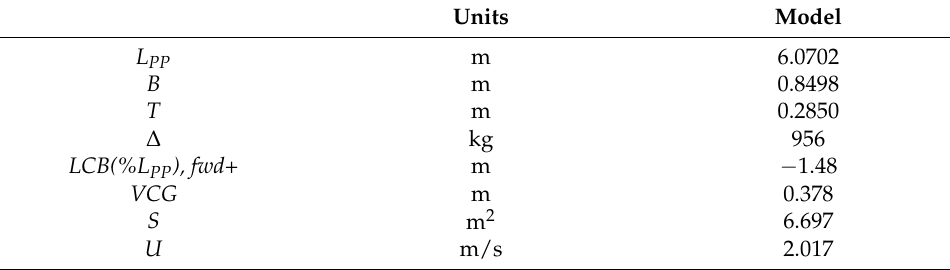
Table 4. Main dimensions of a KRISO containership model.